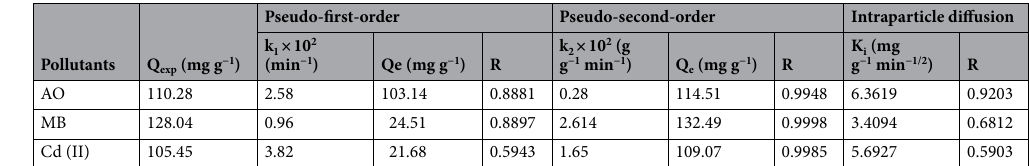
Table 3. Parameters of kinetics model for adsorption of AO, MB, and Cd (II) on ZF-NPS.